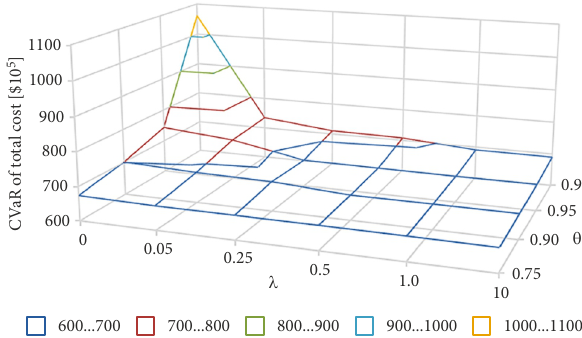
Figure 4. The Pareto frontier for case 10–1 with q